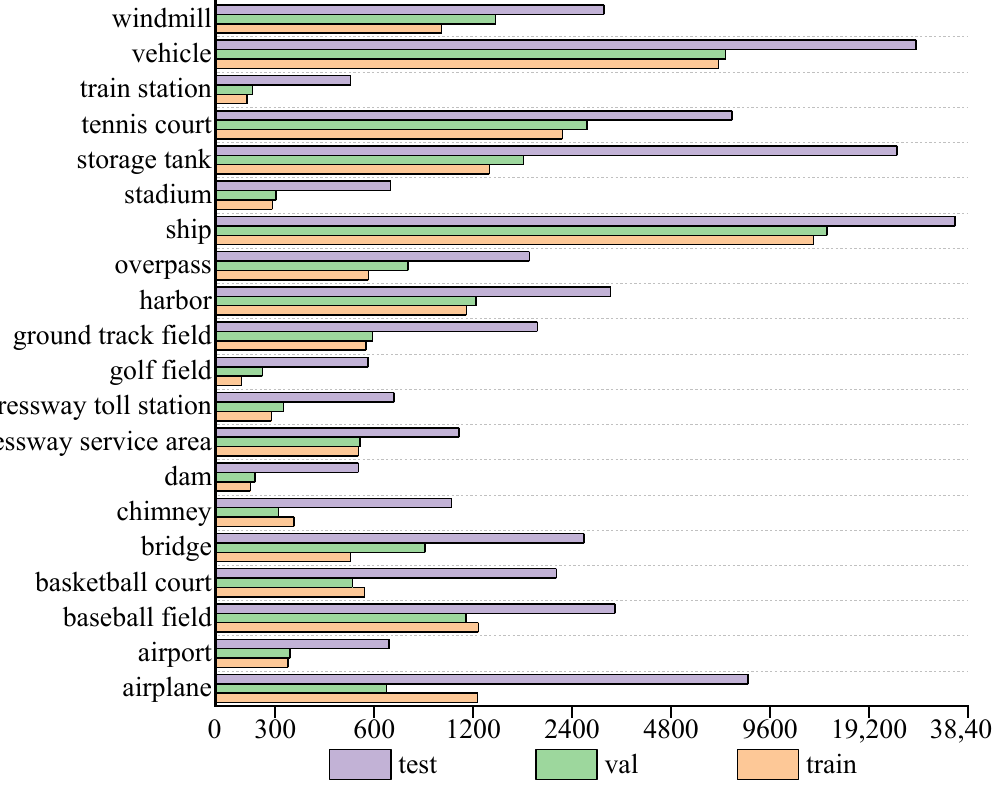
Figure 8. Number of object instances per class in the DIOR dataset.